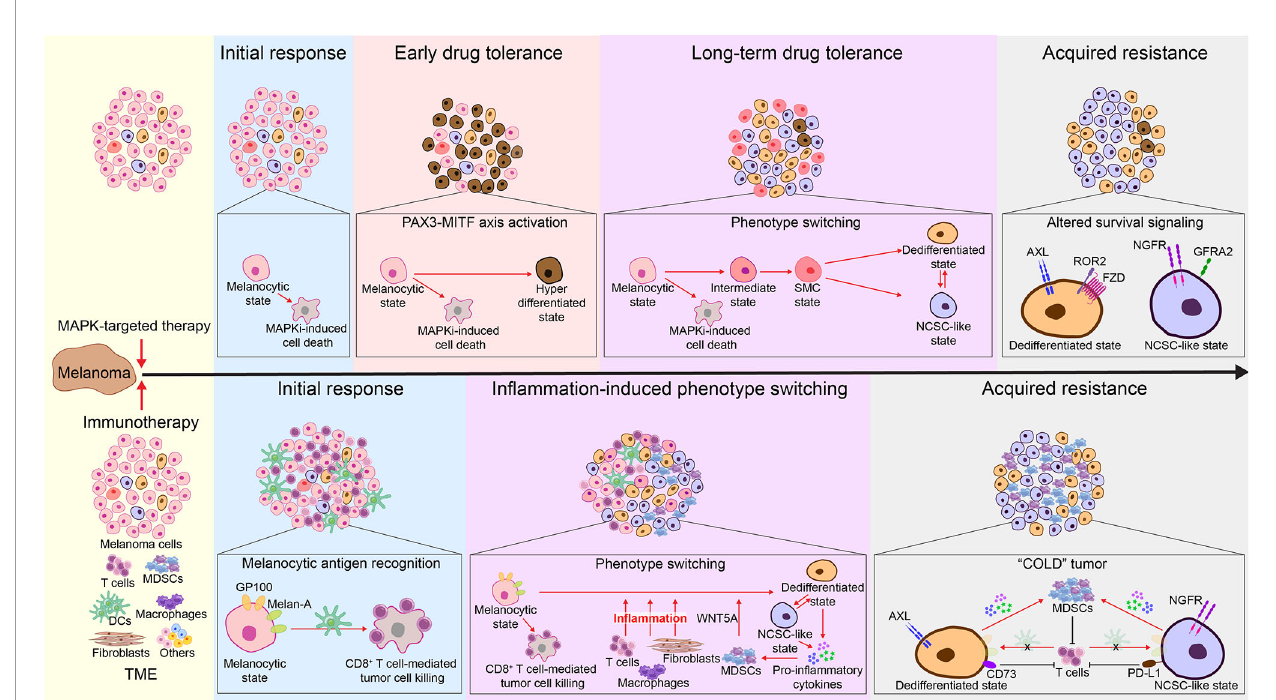
FIGURE 4 | Melanoma phenotype switching in acquired resistance to MAPK-targeted therapy and immunotherapies. Top: During initial response to MAPK-targeted therapy, while melanocytic-state cells are susceptible to MAPKi-induced cell death, a subset of cells switch to a drug-tolerant hyperdifferentiated state mediated by the PAX3-MITF axis. Hyperactivated MITF affords these hyperdifferentiated cells with a survival advantage, enabling them to quickly become the dominant population during the early drug-tolerant phase (16, 185 – 187). In parallel, remaining cells undergo a fatty acid oxidation-dependent metabolic shift, resulting in the emergence of drug-tolerant CD36 + SMC populations (77). These cells undergo a continuous dedifferentiation during prolonged MAPKi treatment resistance (14, 54, 80, 188), resulting in the co-emergence and increase of MITF low /AXL high invasive and MITF low /NGFR high NCSC-like cells (16). These cells express increased levels of cellular receptors, allowing them to grow, bypassing the MAPK signaling and thereby permitting MAPKi resistance (10, 14, 16, 39, 54, 71, 75, 76, 78, 80, 189, 190). Consequently, at the acquired resistance phase, melanomas show a predominant expression of AXL and NGFR (54, 137). Bottom: During initial response to immunotherapy, activated CD8 + T cells recognize melan-A and GP100 antigens expressed on melanocytic-state cells and subsequently eliminate them (7, 31). Meanwhile, immunotherapy- and tumor microenvironment (TME)-induced in fl ammation drives melanoma phenotype switching, leading to decreased expression of melanocytic antigens and increased levels of pro-in fl ammatory cytokines (7, 14, 31, 48). Prolonged in fl ammation leads to increased in fi ltration of MDSCs (48, 146, 191 – 195), which further promote phenotype switching via secretion of WNT5A (191, 192). In the acquired resistance phase, melanomas are enriched for the MITF low /AXL high invasive and MITF low /NGFR high NCSC-like populations (103 – 105). Consequently, these highly dedifferentiated cells escape immune cell recognition (7, 14, 31, 48) and attract high numbers of MDSCs, which further mediate immune suppression (193). In addition, MITF low /AXL high invasive cells are associated with high expression of CD73 (104), and MITF low /NGFR high NCSC-like cells are found to have increased levels of PD-L1 (105, 196), which ultimately contribute to immunotherapy